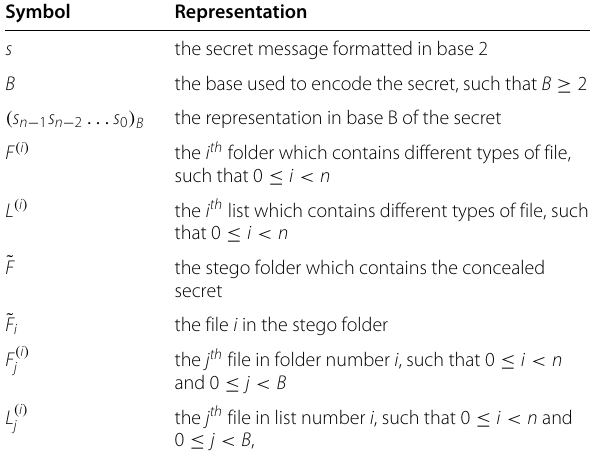
Table 1 symbols and their representations in the proposed approaches